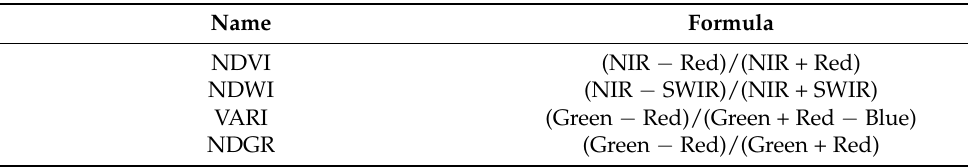
Table 1. Common Vegetation Indices Used to Predict